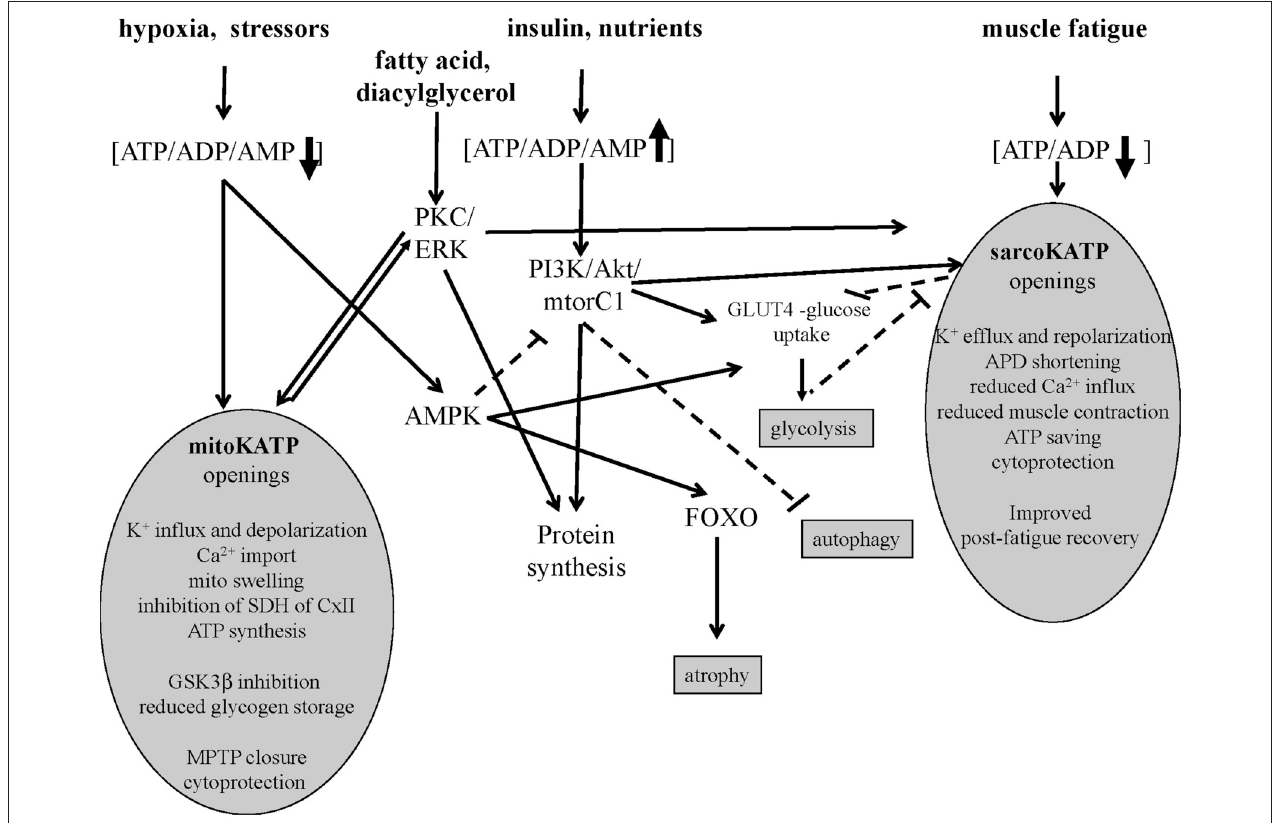
FIGURE 1 | Signaling pathways of sarco-KATP and mito-KATP channels in skeletal muscle. Hypoxia-induced lowering of ATP/ADP/AMP ratio activates mito-KATP channel with mito-swelling, inhibition of succinic dehydrogenase(SDH) of complex II, ATP synthesis, inhibition of glycogen-synthase-kinase-3beta(GSK3 β ), closure of the mitochondrial permeability transition pore(MPTP). The high ATP/ADP/AMP ratio activates the phosphatidylinositol-3 kinase/protein kinase B /mammalian target of rapamycin complex1(mtorC1) (PI3K/Akt/mtorC1) pathway. The AMP-activated protein-kinase(AMPK) inhibits mtorC1 and activates forkhead box protein O(FOXO). The lowering of ATP/ADP ratio following fatigue activates the sarco-KATP channels with improved post-fatigue recovery. In slow twitch fibers, protein kinase C(PKC) and extracellular signal-regulated kinases(ERK) may activates sarco-KATP and mito-KATP channels with cytoprotection. Continuous line indicates activation, dashed line